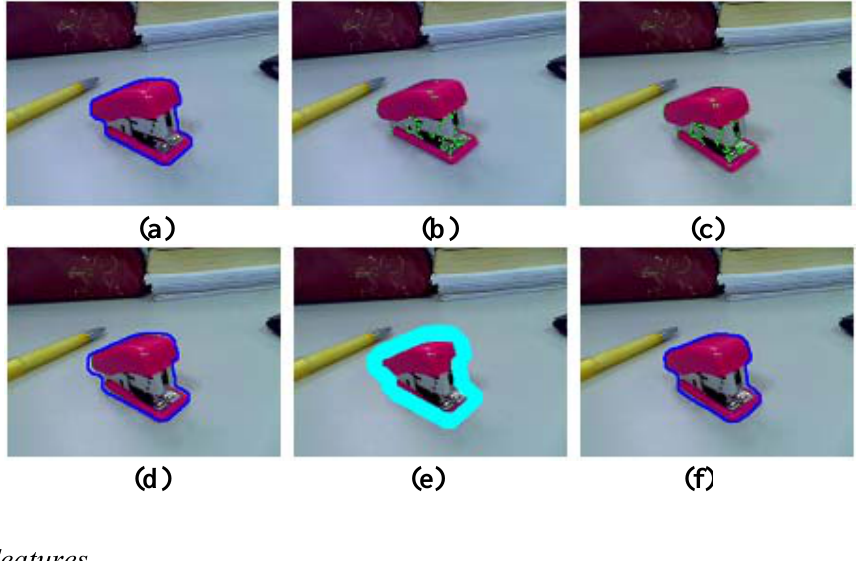
Figure 3. The steps of object tracking. (a) The object contour features detected in frame I at time 1  t . (c) The tracked features in frame J at time t . ˆ of frame (d) The coarse contour C J at time t . (e) The banded area t C of frame J at time t contour t